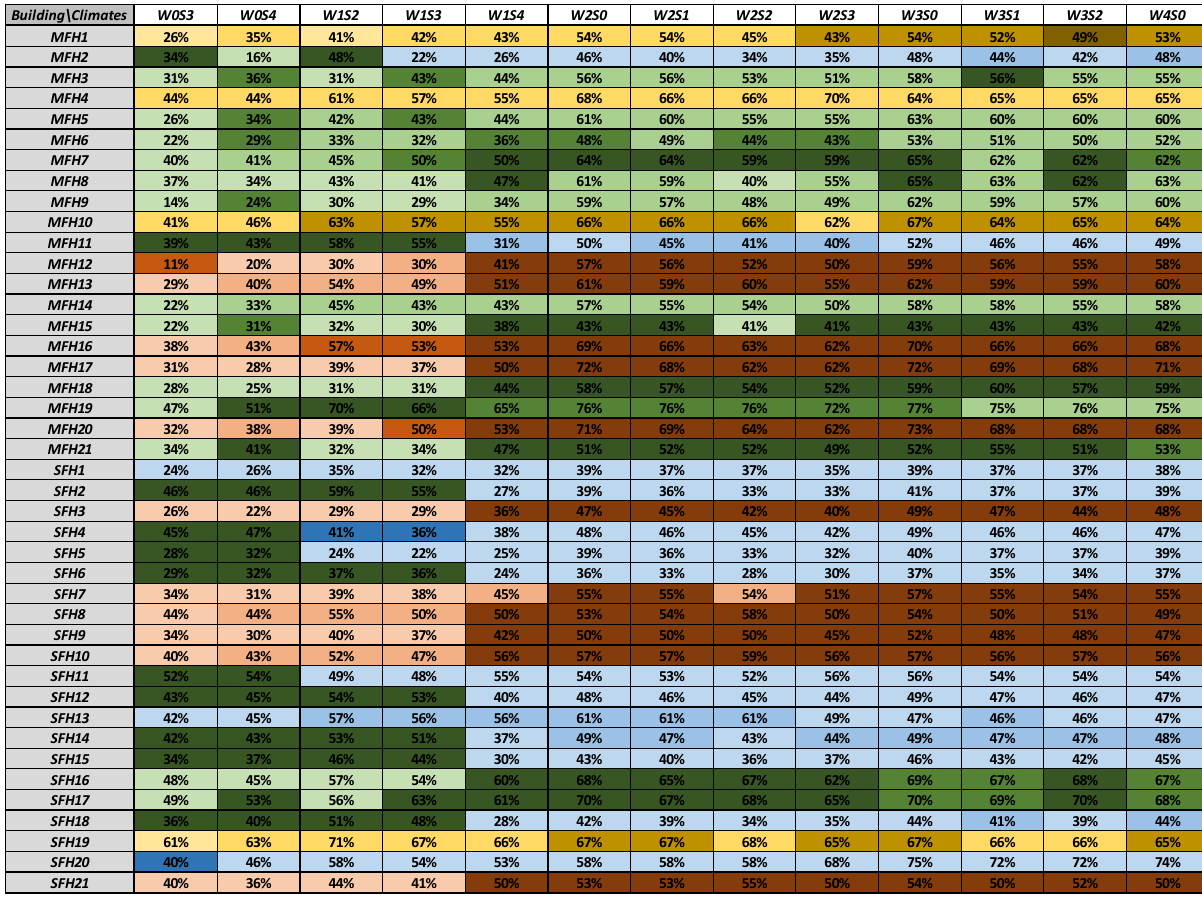
Figure 2. Percentage of energy savings regarding the validated POS for each reference building and climate combination.